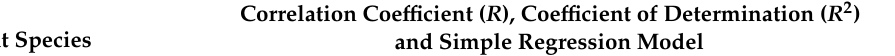
Figure 3. Correlations between leaf impedance and leaf nitrogen concentration (LNC) for four different plant species. The coefficient of determination ( R 2 ) is extracted for canola ( a ) linear 0.03; ( b ) polynomial 0.03; for wheat ( c ) linear 0.13; ( d ) polynomial 0.15; for soybeans ( e ) linear 0.08; ( f ) polynomial 0.11; and for corn ( g ) linear 0.18; ( h ) polynomial 0.19. Table 1. Correlations between leaf nitrogen concentration (LNC) and leaf impedance ( Z ) for di ff erent plant